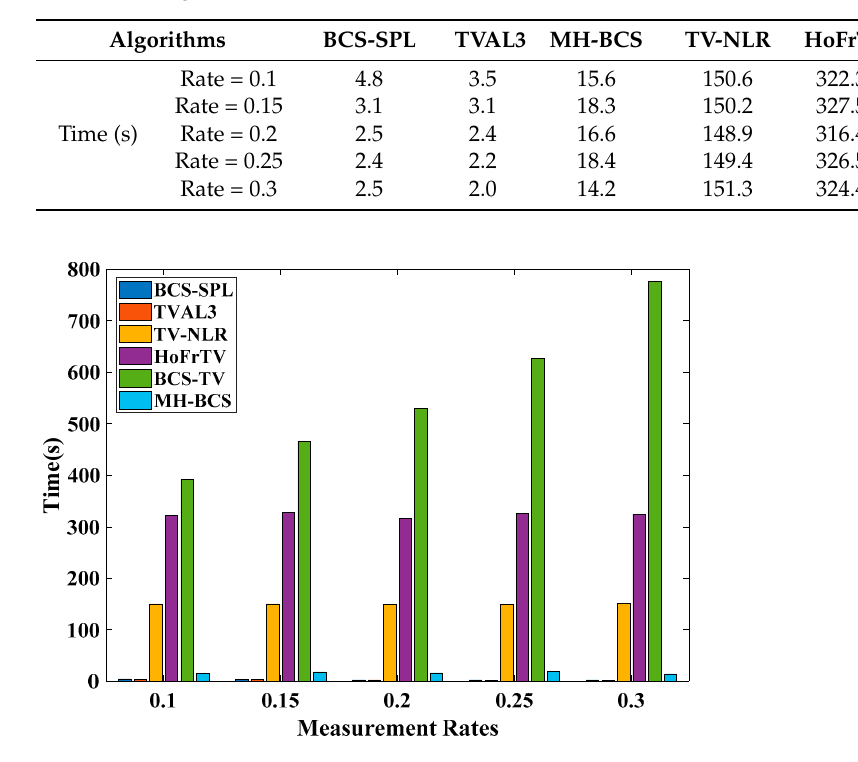
Figure 9. Average reconstruction time (s).